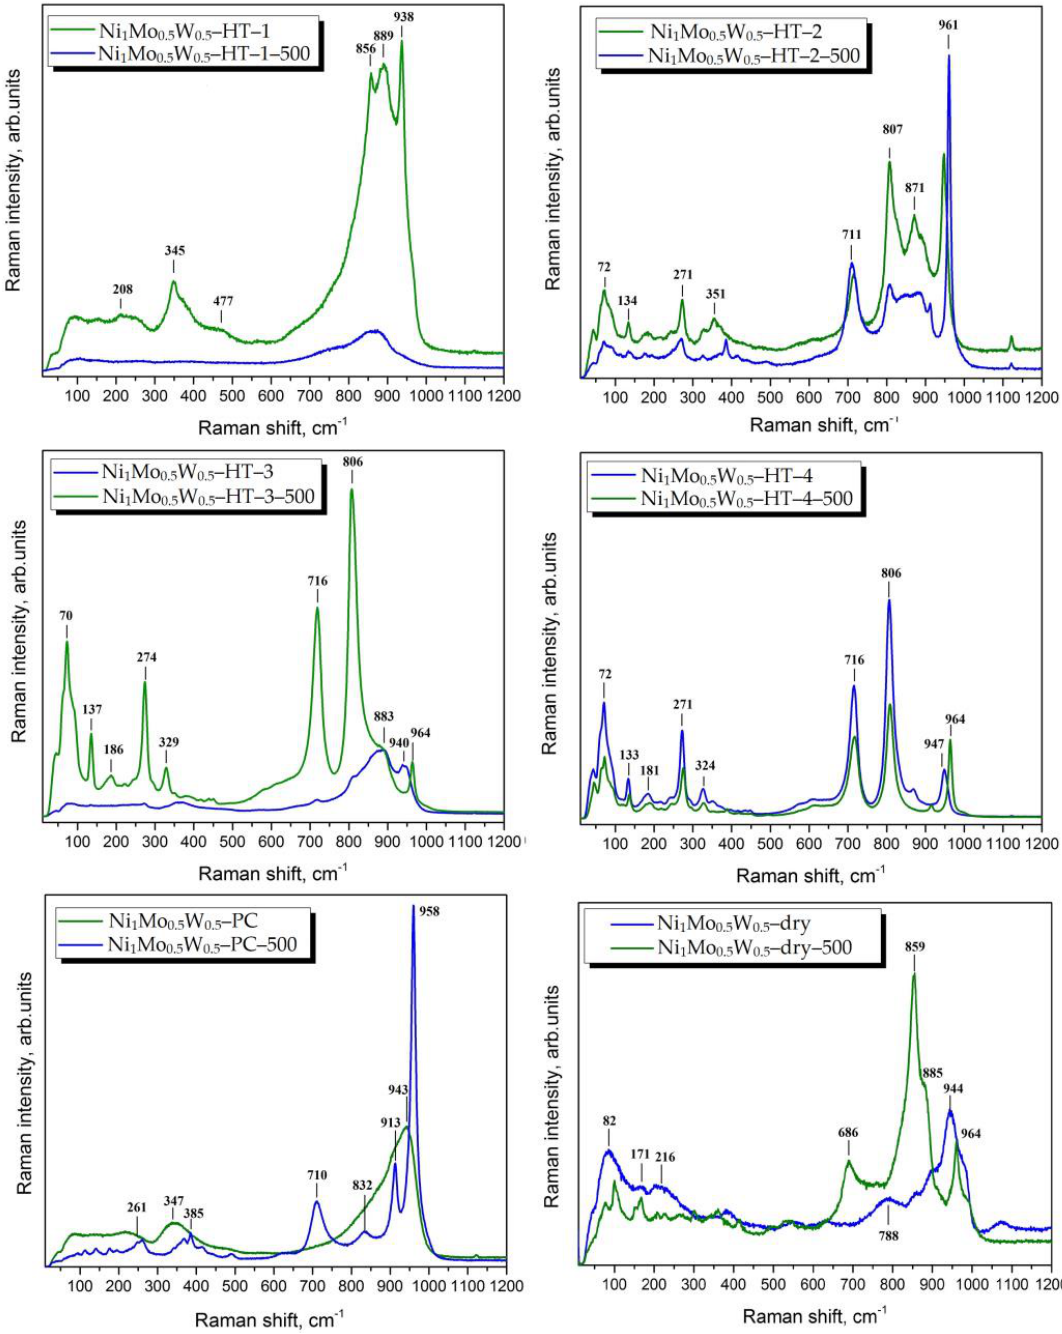
Figure 6. Raman spectra of catalyst precursors dried at different temperatures. Catalysts dried at different temperatures were evaluated by Raman